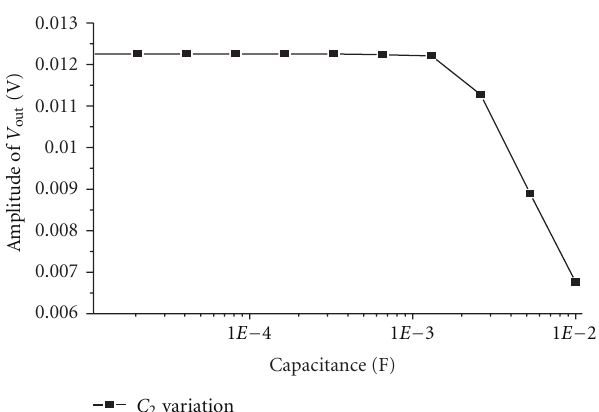
Figure 24: Relation curve between the T temperature and the Amplitude of V out according to